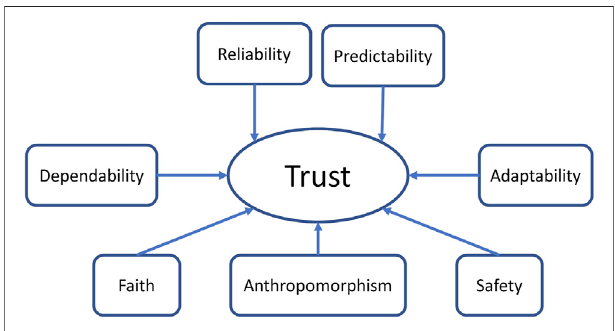
FIGURE 4 | Potential trust factors included in this